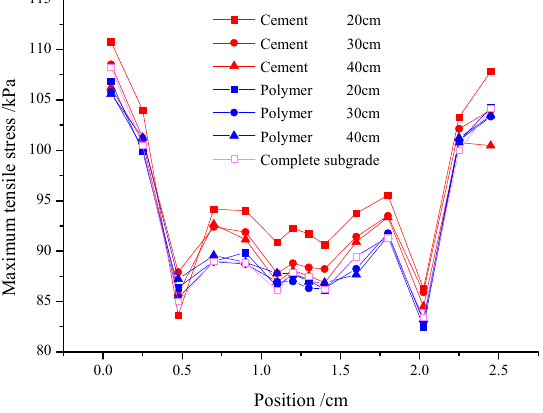
Figure 10. Variation of stress at the bottom of track slab with different thickness of lifted layer.